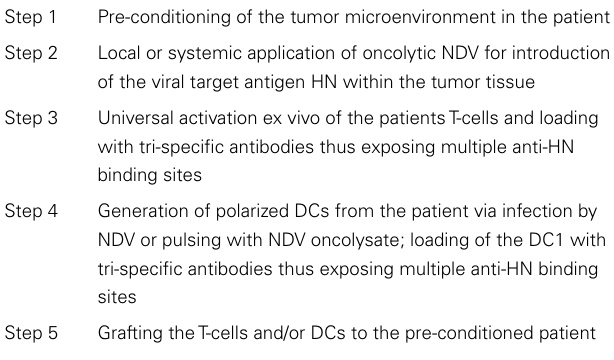
Table 1 |Adoptive cellular cancer therapy: targeting a viral antigen (e.g., HN) by graftedT-cells and DCs via cell-bound tri-specific antibodies